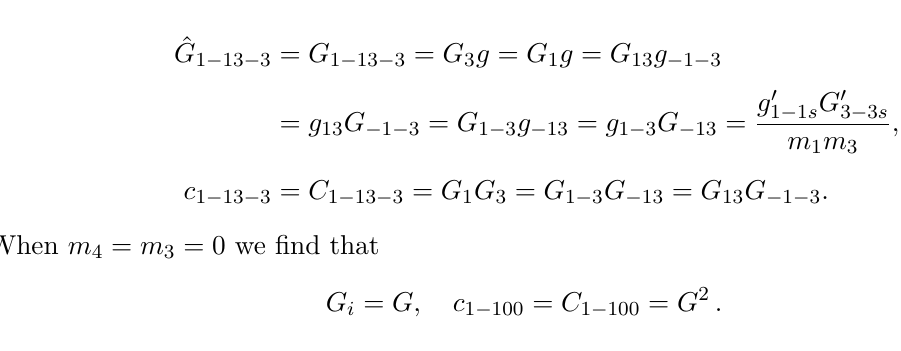
Figure 4 . Feynman diagrams showing the AA → φφ process for m I + m J = 0 case. The bold curly line represents a gluon, where m 12 = 0 and the straight line a scalar